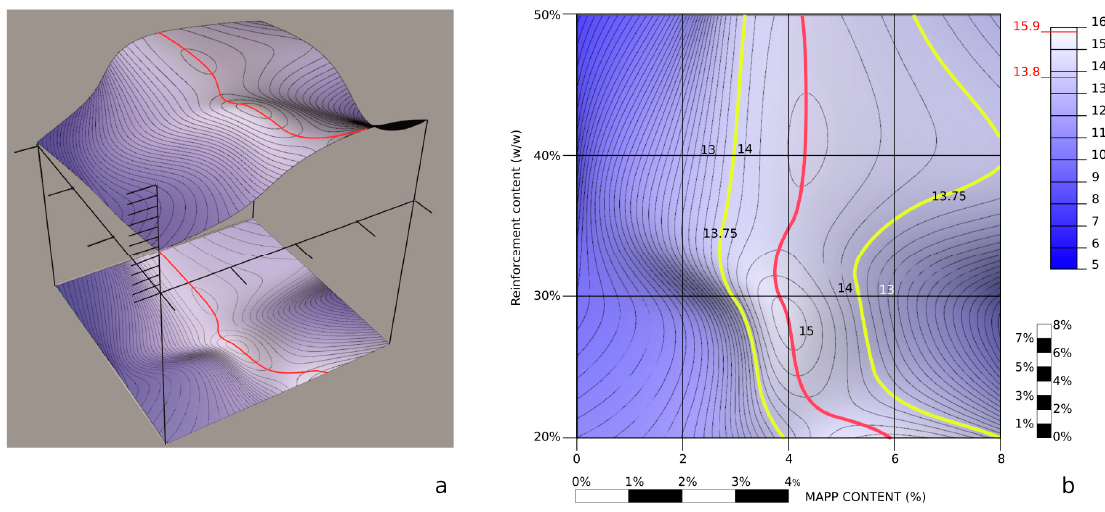
Figure 6. Topographic profile of the interfacial shear strength against coupling agent and reinforcement contents; ( a ): 3d process used to obtain iso- τ lines, ( b ): 2d view of the topographic profile.